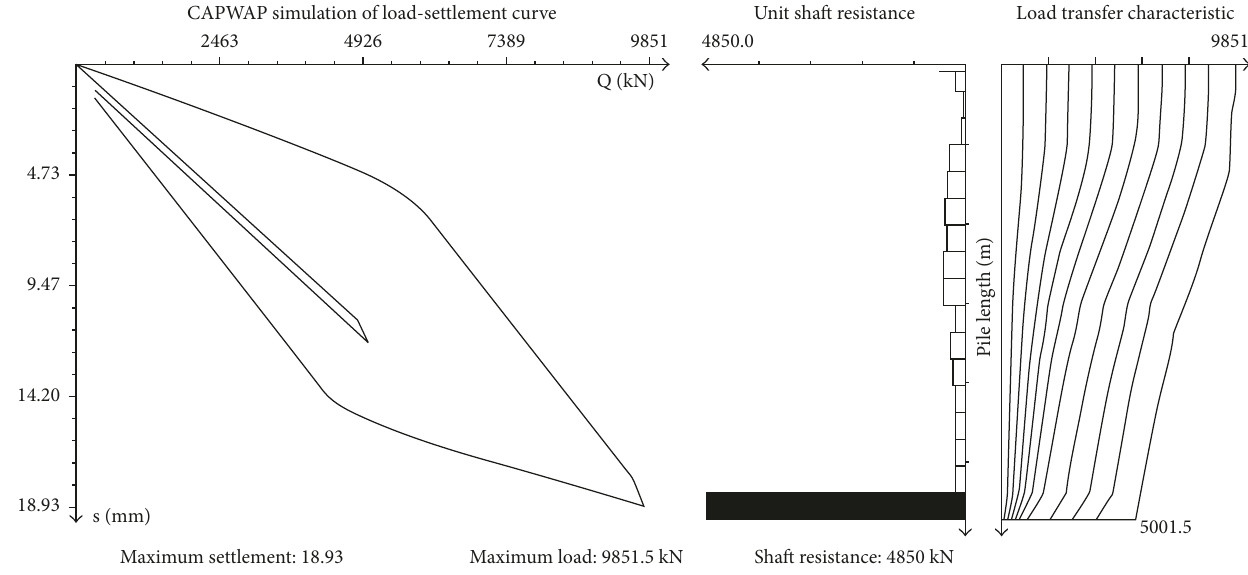
Figure 16: Simulated load-settlement curve, unit shaft resistance, and load transfer characteristic of P126.